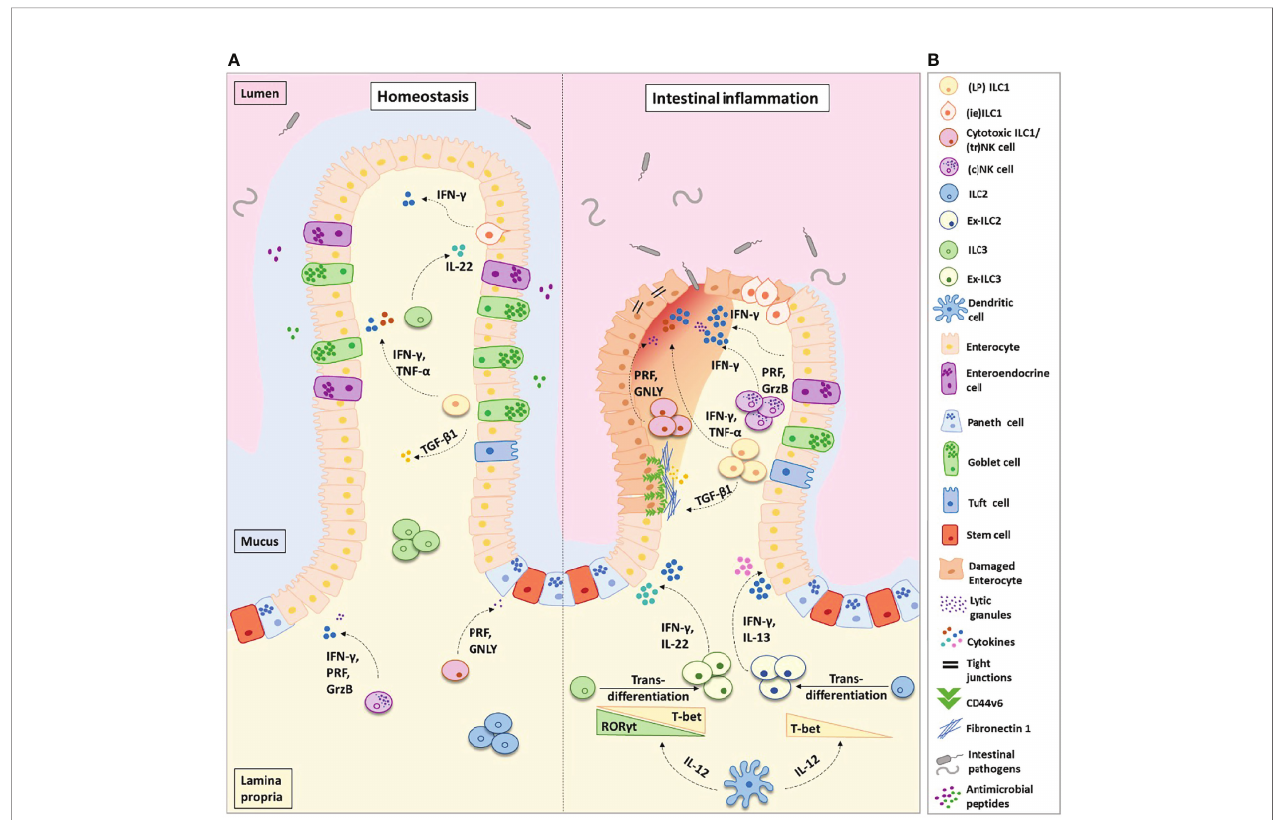
FIGURE 1 | Helper-like type 1 ILCs (ILC1s) in homeostasis and intestinal in fl ammation. (A) ILC1s comprise of lamina propria (LP) ILC1s, intra-epithelial (ie) ILC1s, and cytotoxic ILC1s/tissue-resident (tr) natural killer cells. In the healthy intestinal microenvironment, ILC1s are the least frequent ILC population. In in fl ammatory bowel disease (IBD), the frequency of ILC1s is increased at the expense of ILC3s and ILC2s. ILC3s and ILC2s transdifferentiate into ILC1s aided by the secretion of IL-12 from dendritic cells. Ex-ILC3s can secrete both IFN- g and IL-22 upon stimulation, while ex-ILC2s can produce both IFN- g and IL-13. The increase in ILC1 frequency leads to an increase in pro-in fl ammatory cytokine secretion and augmented levels of ILC1-derived TGF- b 1. TGF- b 1 has been shown to increase CD44v6 + expression in epithelial and mesenchymal cells. In homeostasis, this may aid wound healing; however, in IBD this is associated with enhanced fi bronectin-1 deposition and extracellular matrix degradation, consequently promoting tissue scarring. Abundant levels of IFN- g disrupt the epithelial tight junctions, leading to increased epithelial permeability. This allows commensal, pathogenic, and opportunistic bacterial species (such as Bacteroides fragilis , Escherichia coli , Mycobacterium avium subsp. paratuberculosis , and C. dif fi cile ) to penetrate the lamina propria, thus perpetuating the in fl ammation. (B) Figure key illustrating the different cell types and molecules participating in intestinal in fl ammation. IFN- g , interferon-gamma; IL-22, interleukin-22; IL-17, interleukin-17; IL-13, interleukin-13; IL- 12, interleukin-12; TGF- b 1, transforming growth factor-beta 1; TNF- a , tumor necrosis factor-alpha; PRF, perforin; GrzB, granzyme-B; GNLY,